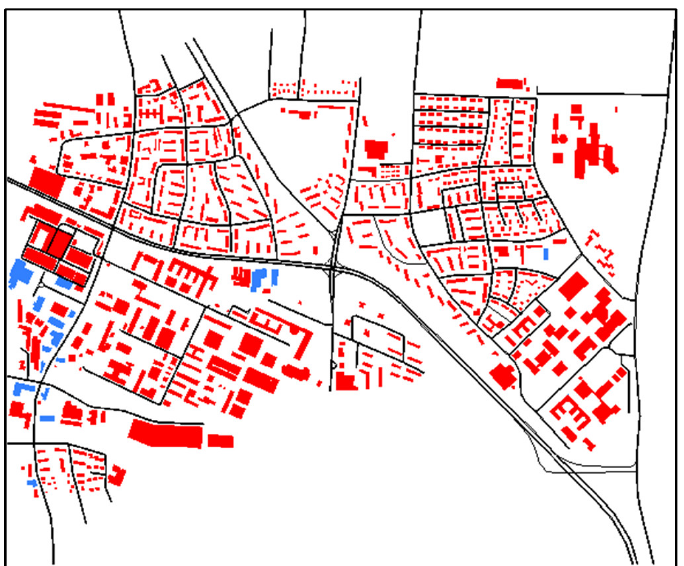
Figure 3. Network Map .